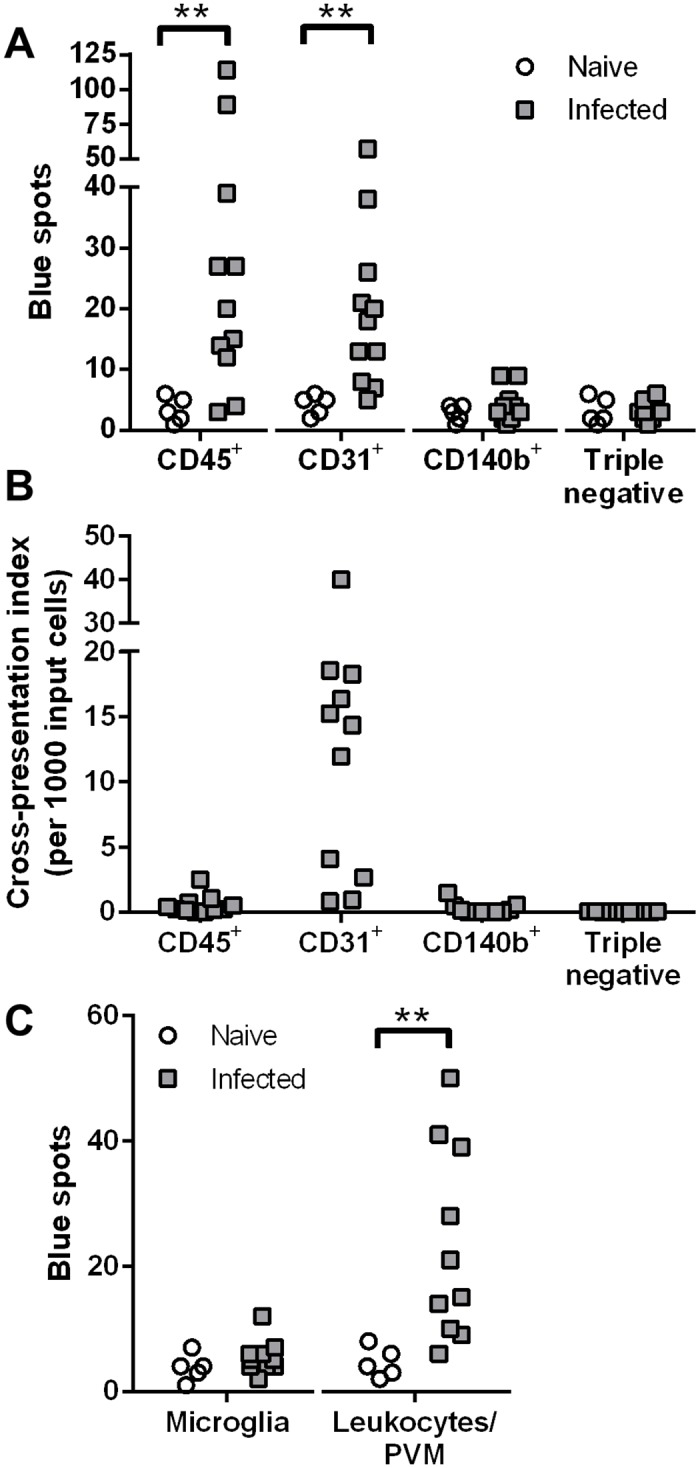
Endothelial cells and leukocytes are the cross-presenting cells in the brain during PbA infection.(A–B) Brains from naïve (n = 5) and PbA-infected mice exhibiting signs of ECM (n = 11) were subjected to automated dissociation using papain. After myelin removal, the single cell suspensions were stained and sorted into four populations: CD45+ microglia and leukocytes, CD45-CD31+ endothelial cells, CD45-CD140b+ cells including pericytes, and cells negative for all three markers. Each sorted population was tested for cross-presentation by incubating with LR-BSL8.4a cells and staining with X-gal. Data were pooled from 3 independent experiments. (A) Raw spot counts. **P< 0.01, separate Mann-Whitney U tests comparing naïve vs infected for each population. (B) Only data from infected mice are shown, after background subtraction (the mean of all naïve wells) and normalization by the number of sorted cells added. Negative data are plotted as zeroes. (C) Brains from naïve (n = 5) and PbA-infected mice (n = 10) were manually dissociated and digested with collagenase. After myelin removal, the single cell suspensions were stained and sorted for microglia (CD45intCD11b+) and peripheral leukocytes together with PVM (CD45hi), which were assayed for cross-presentation as above. Data were pooled from 2 independent experiments. **P< 0.01, Mann-Whitney U test. See S1 Fig for representative FACS plots.